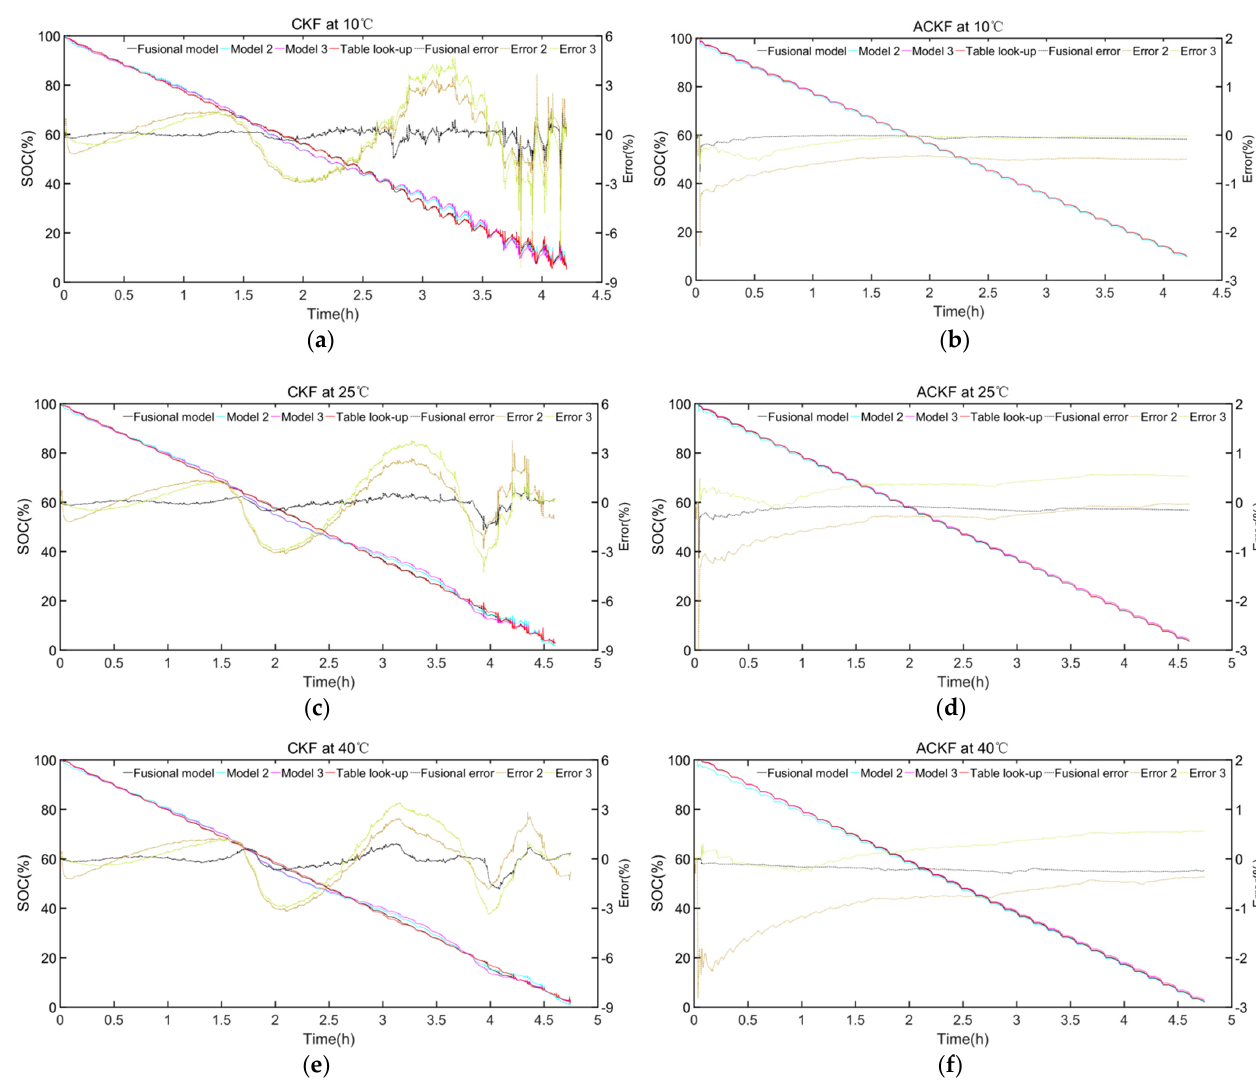
Table 7. RMSE of SOC estimation for NMC battery (%).